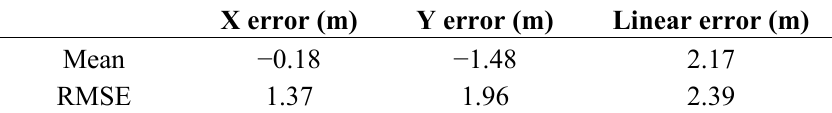
Table 4. Errors obtained in absolute coordinates of 20 traffic